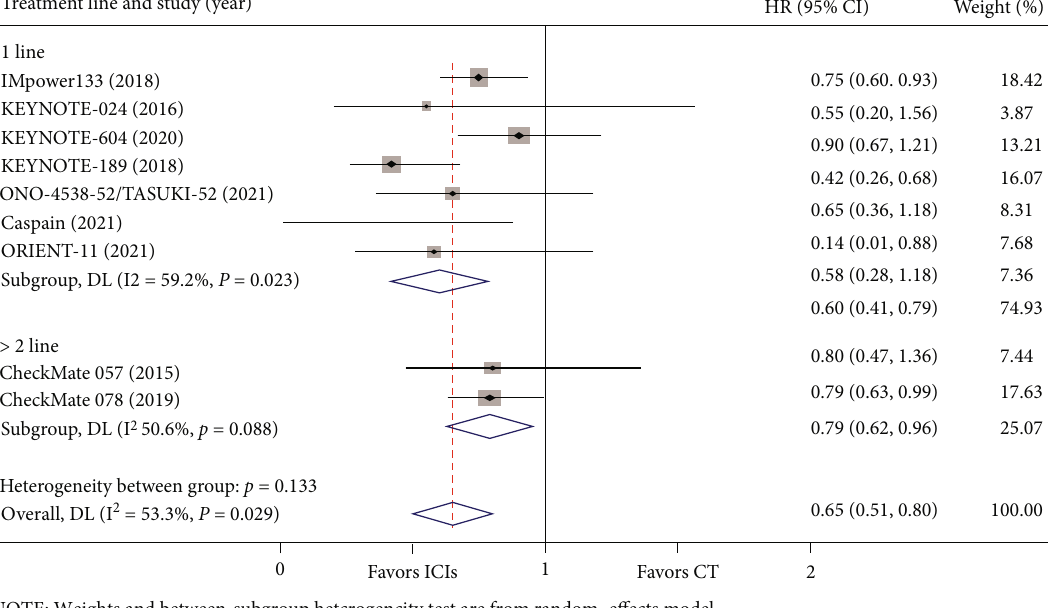
Figure 10: Subgroup analyses of PFS by treatment line between the immune checkpoint inhibitors (ICIs) group and the chemotherapy (CT) group for lung cancer with